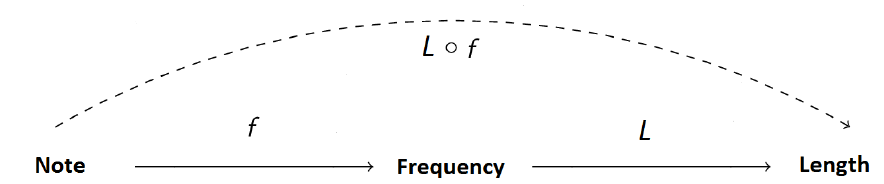
Figure 2. The relation between the notes played by a Pan’s flute, their corresponding frequency, and the length of pipes as a composition of